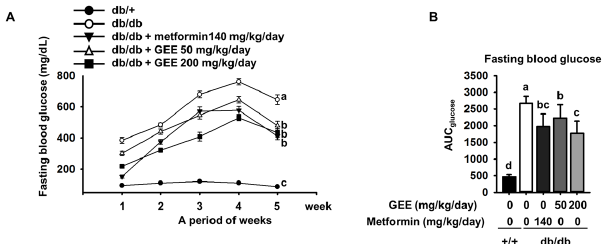
Figure 2. Effect of GEE on fasting blood glucose in db/db mice. Prior to measurement, five-week-old mice were fasted for 12 h during the dark period. Blood glucose levels were measured weekly. The mice were treated with or without GEE (50 and 200 mg/kg/day) ( A ). Area under the curve for glucose (AUC glucose) was calculated using the trapezoidal rule ( B ). Differences between time-points and treatments were analyzed by two-way ANOVA followed by Tukey’s multiple comparisons post hoc test. Data are mean ± SD. ( n = 8 per group, a p < 0.05, b p < 0.01, c p < 0.001).